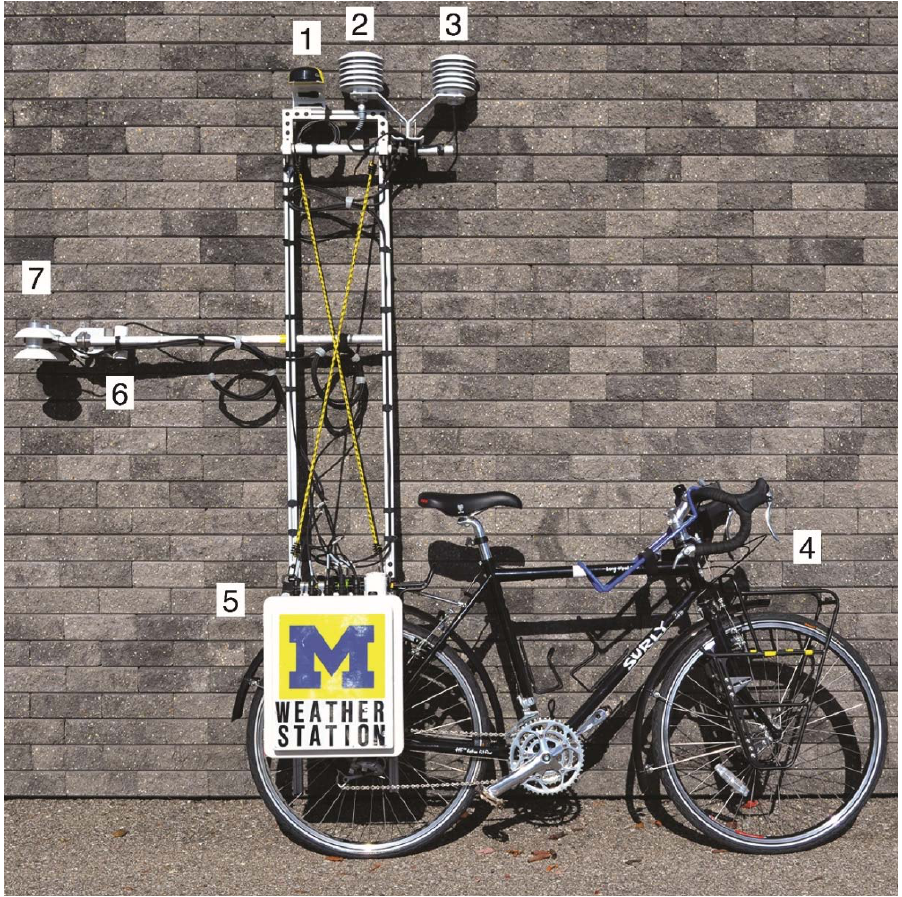
Figure 1. Image of the bicycle-based mobile measurement system: ( 1 ) GPS; ( 2 ) relative humidity and air temperature; ( 3 ) air temperature; ( 4 ) sky view factor camera location (not shown); ( 5 ) datalogger and barometric pressure; ( 6 ) ground surface temperature; ( 7 ) four component net